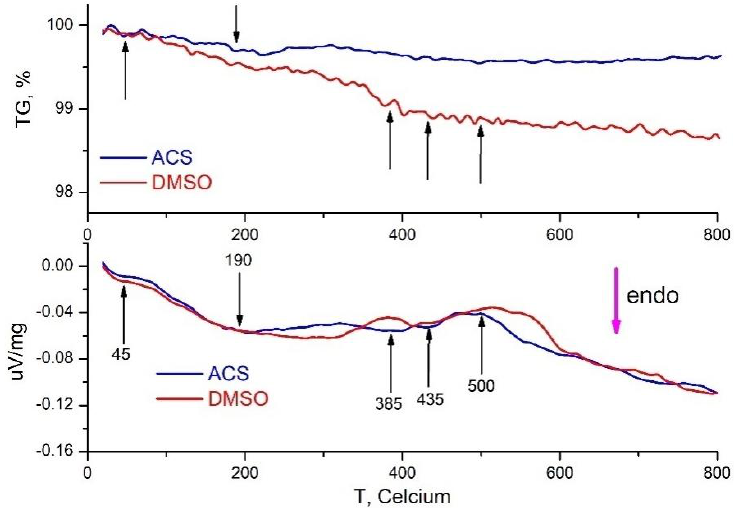
Figure 10. Differential scanning calorimetry (DSC) (lower figure) with synchronized thermogravimetric analysis (upper figure) of the 0.1 at. % Nd 3+ :LaF 3 nanoparticle powders obtained by drying at 80°C aqueous (ACS, blue curves) and DMSO (DMSO, red curves) colloids of nanoparticles.